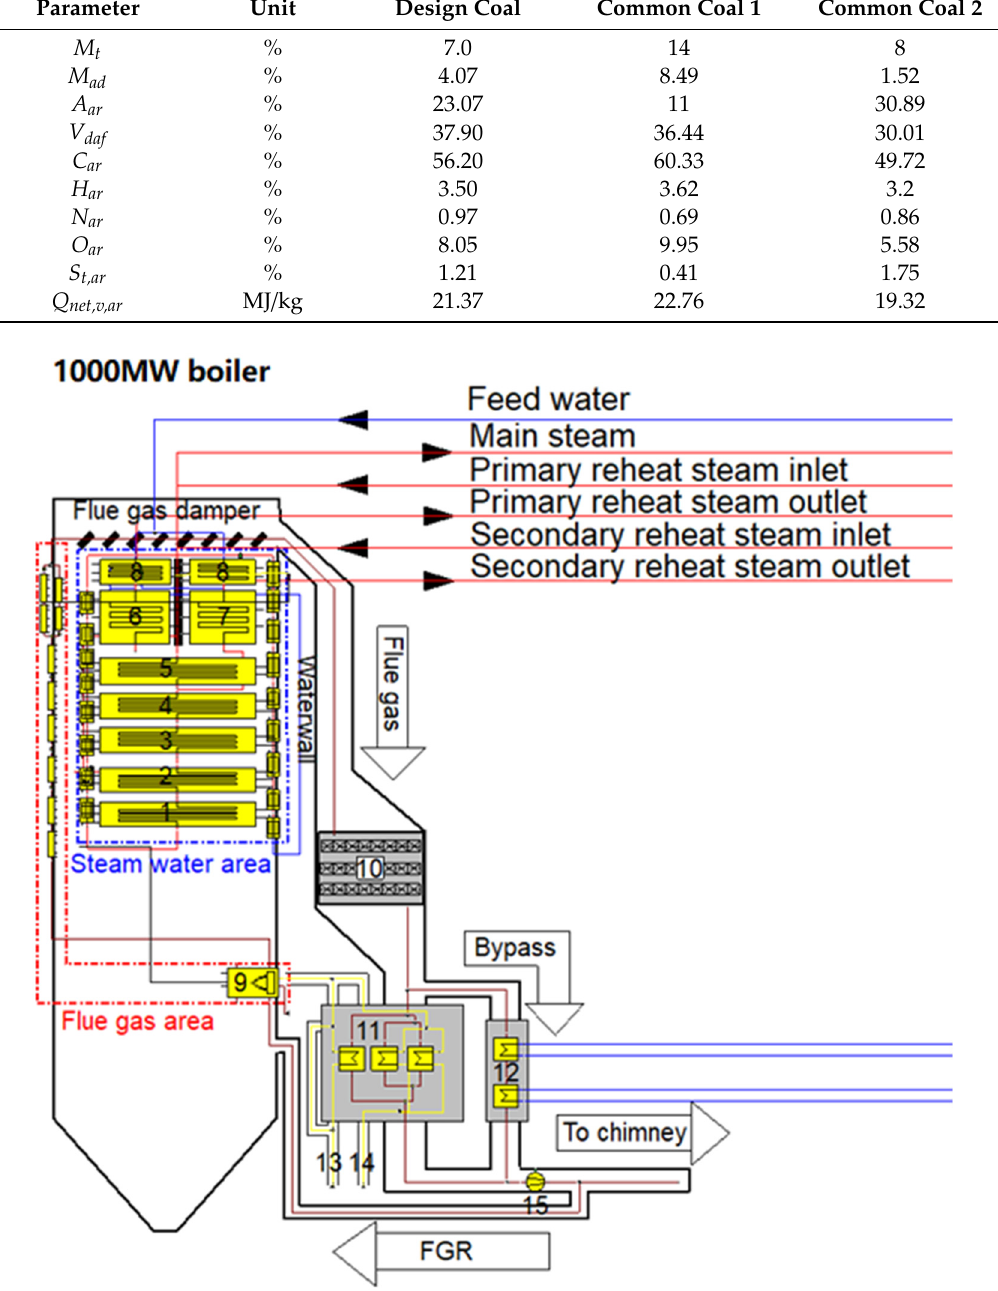
Figure 1. EBSILON simulation boiler model. 1—primary superheater; 2—tertiary superheater; 3—high-pressure and high-temperature reheater; 4—low-pressure and high-temperature reheater; 5—secondary superheater; 6—low-pressure and low-temperature reheater; 7—high-pressure and low- temperature reheater; 8—economizer; 9—burner; 10—denitration device; 11—APH; 12—APH bypass